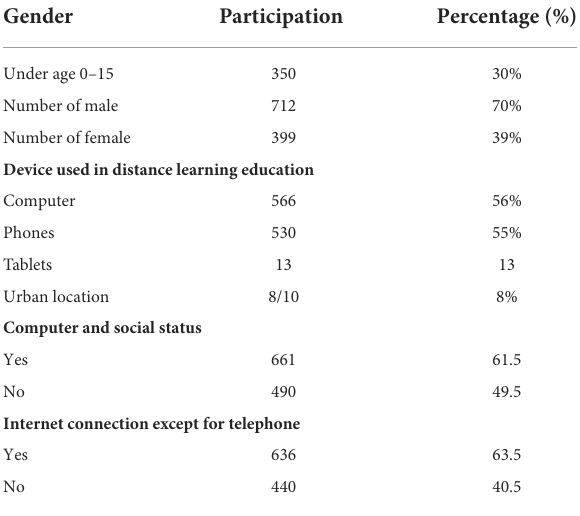
TABLE 2 Demographic information of the participants.